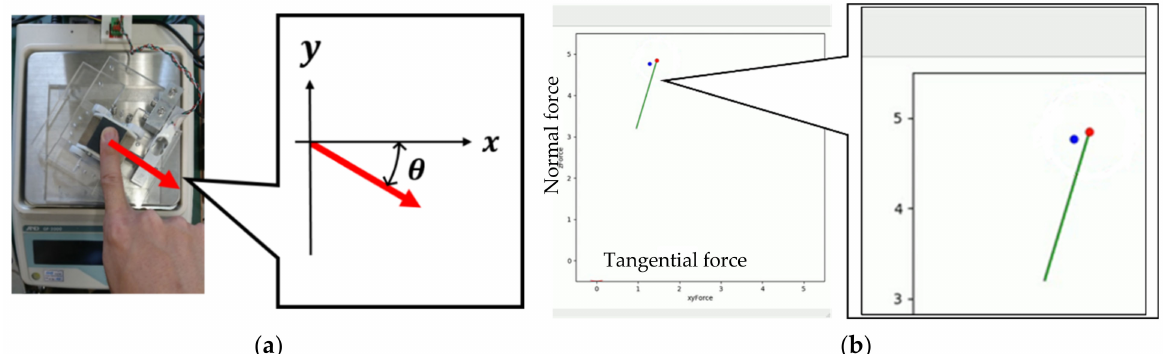
Figure 3. Measurement equipment and force generation instruction: ( a ) A volunteer touches the top of a slider with his right index finger while simultaneously applying normal force and tangential force to it according to instructions shown on an LCD monitor. ( b ) The LCD monitor shows the force reference with the red point and the instruction history by the green line within 5 s. The volunteer adjusts the force applied to the top surface of the slider to match the current force shown by the blue point to the red point.